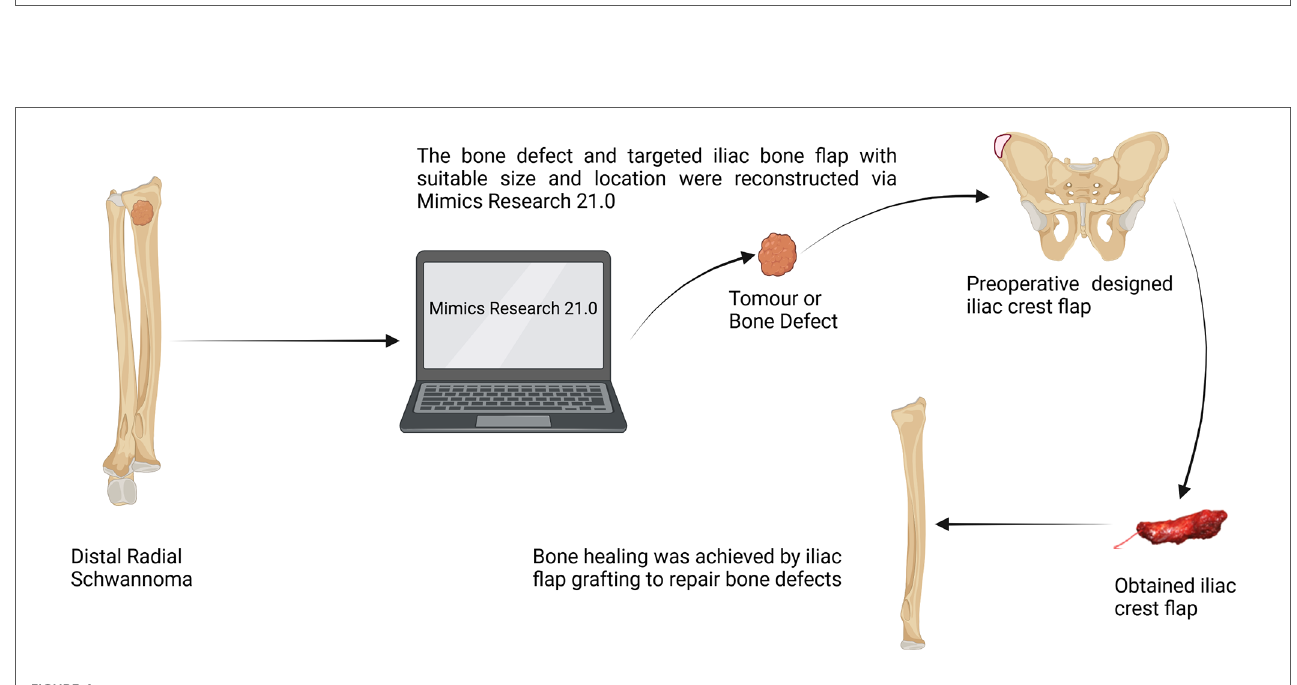
FIGURE 4 Flow chart of surgery